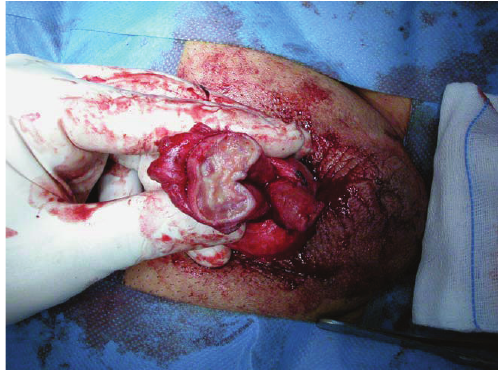
Figure 3: Penile amputation to eliminate all the necrotic tissue surrounding the extruded